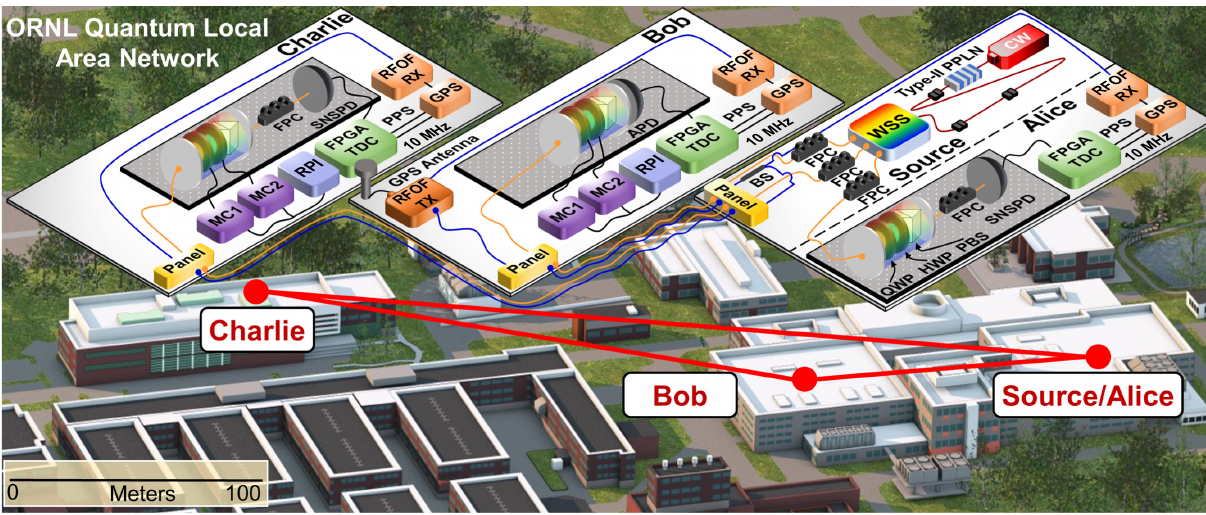
FIG. 4. Map of QLAN on the ORNL campus. The receiver configurations at each node are shown as insets. APD, avalanche photo- diode; CW, continuous-wave laser; FPC, fiber polarization controller; FPGA, field-programmable gate array; GPS, Global Positioning System; HWP, half-wave plate; MC, motion controller; Panel, fiber-optic patch panel; BS, beam splitter; PBS, polarizing beam split- ter; PPLN, periodically poled lithium niobate; PPS, pulse per second; Source, entanglement source; QWP, quarter-wave plate; RFOF RX, rf over fiber receiver; RFOF TX, rf over fiber transmitter; RPI, Raspberry Pi microprocessor board (to control MCs); SNSPD, superconducting nanowire single-photon detector; WSS, wavelength-selective